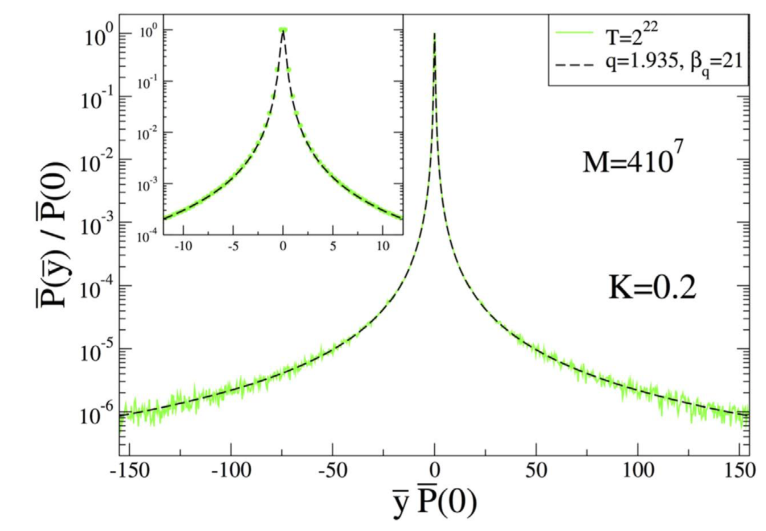
Figure 11. Normalized probability distribution function for K = 0.2 with T = 2 22 . From [100].